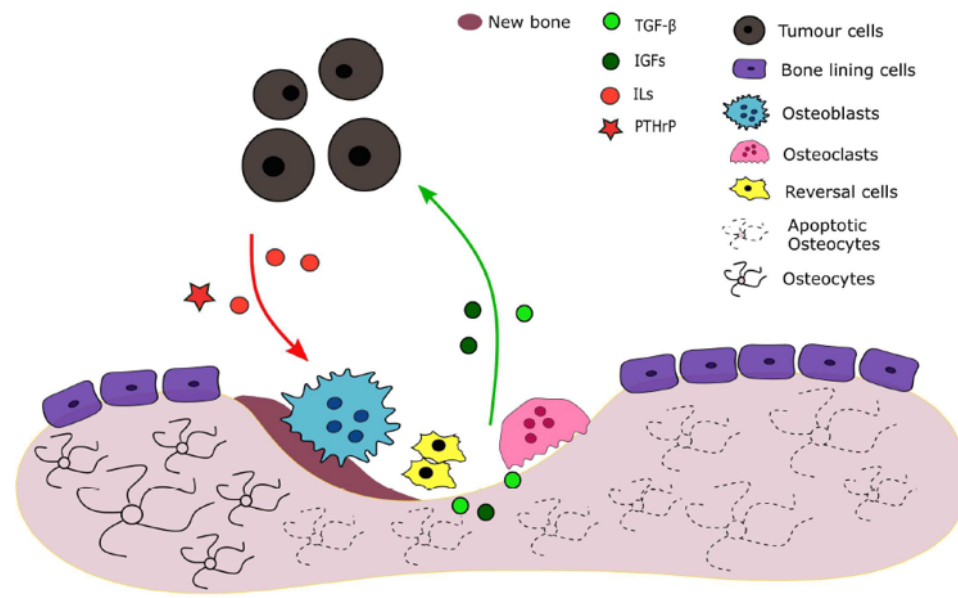
Figure 1. Tumour influence on bone